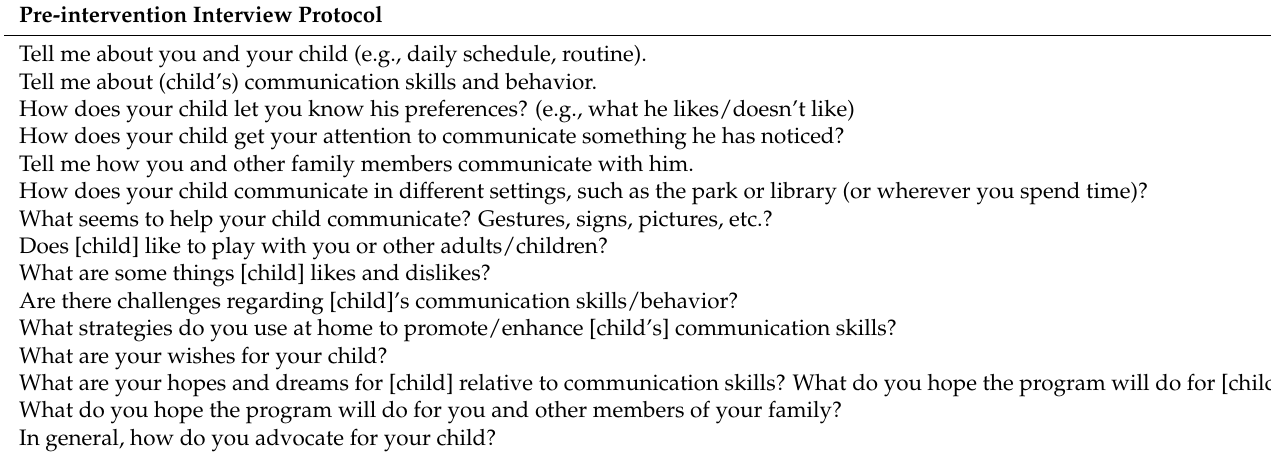
Table 2. Interview